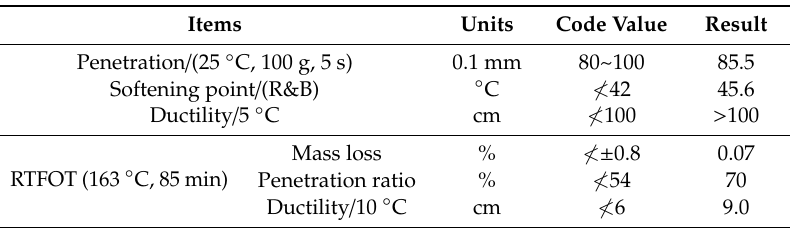
Table 1. Properties of base